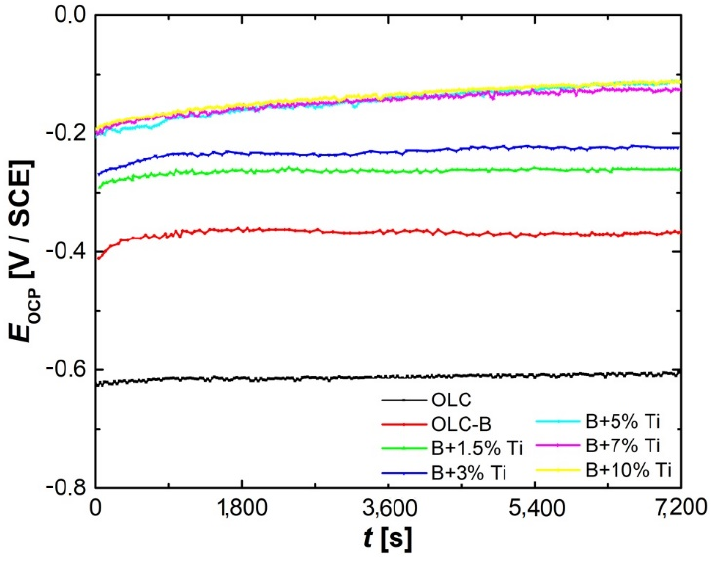
Figure 5. OCP evolution for mild steel without and with NiCr(Ti) coatings test samples recorded in test solution.